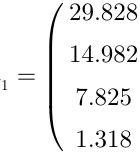
and without reported RVF mortality. The average misclassification rate (4.2%) was estimated through cross-validation. The following linear discriminant function could thus be used to predict if a site had or did not have reported RVF mortalities: